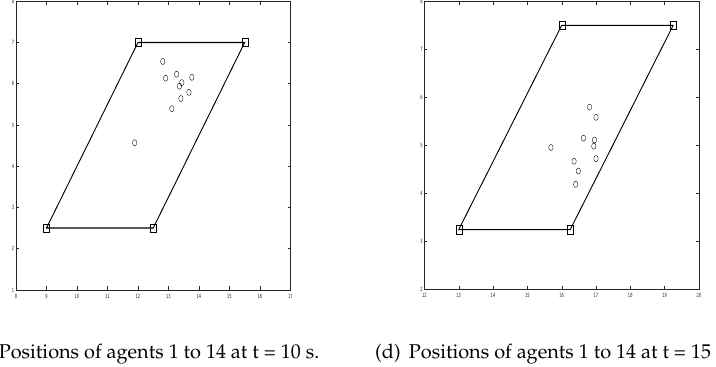
Figure 2. Positions of agents 1 to 14 using Algorithm 1, where squares denote leaders and circles denote followers.